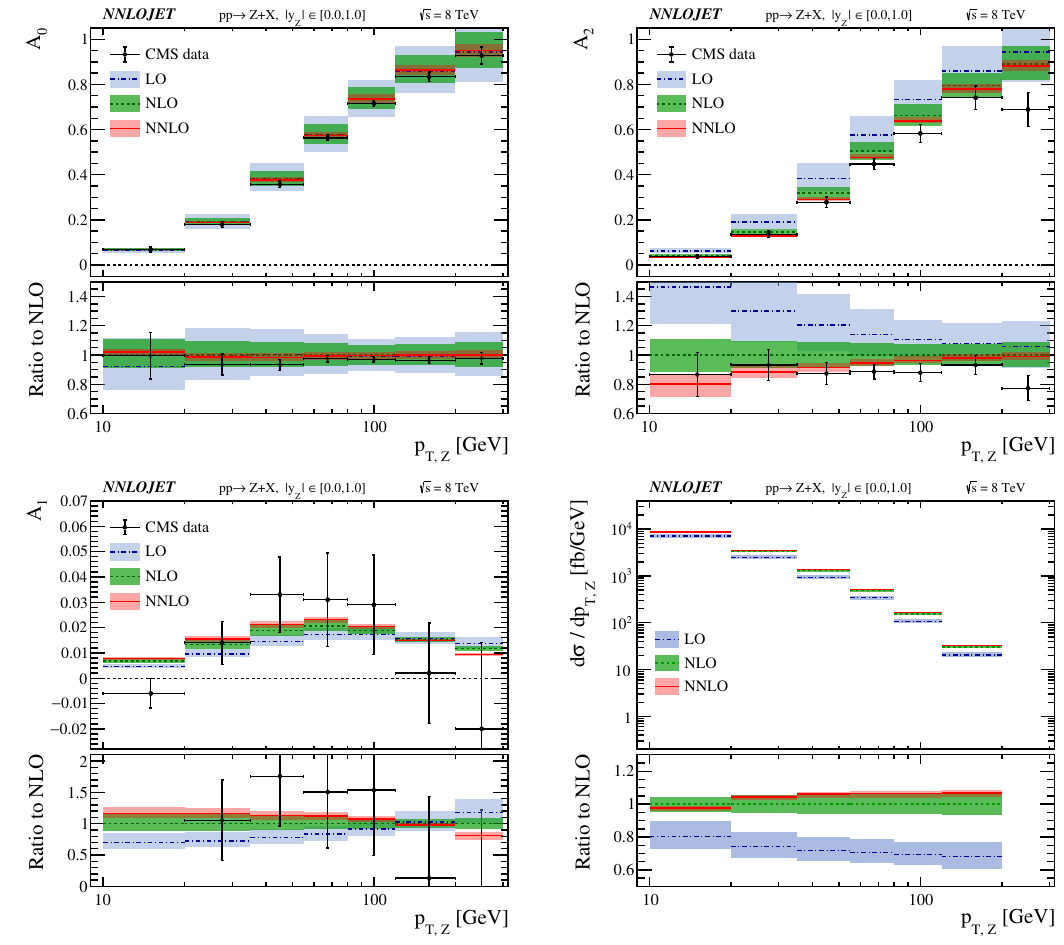
Figure 6 . The p T ; Z distribution for the angular coe(cid:14)cients A 0 (upper left), A 2 (upper right), A 1 (lower left), as well as the unpolarised cross section (lower right) in pp collisions at a kinematic cut of j y Z j 2 [0 : 0 ; 1 : 0] is required for all distributions. The CMS data (black points) are compared to the LO (blue (cid:12)ll), NLO (green (cid:12)ll), and NNLO (red (cid:12)ll) theoretical predictions. In the lower panel, each distribution is shown normalised with respect to the central NLO